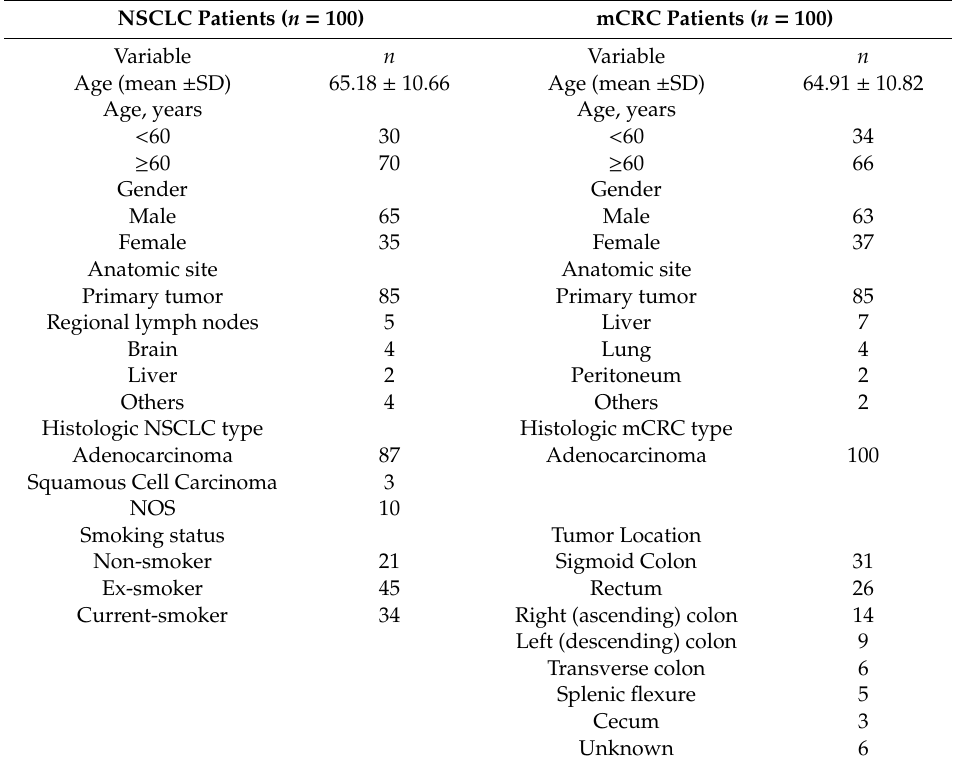
Table 3. Epidemiological and clinical-pathological characteristics of the patients